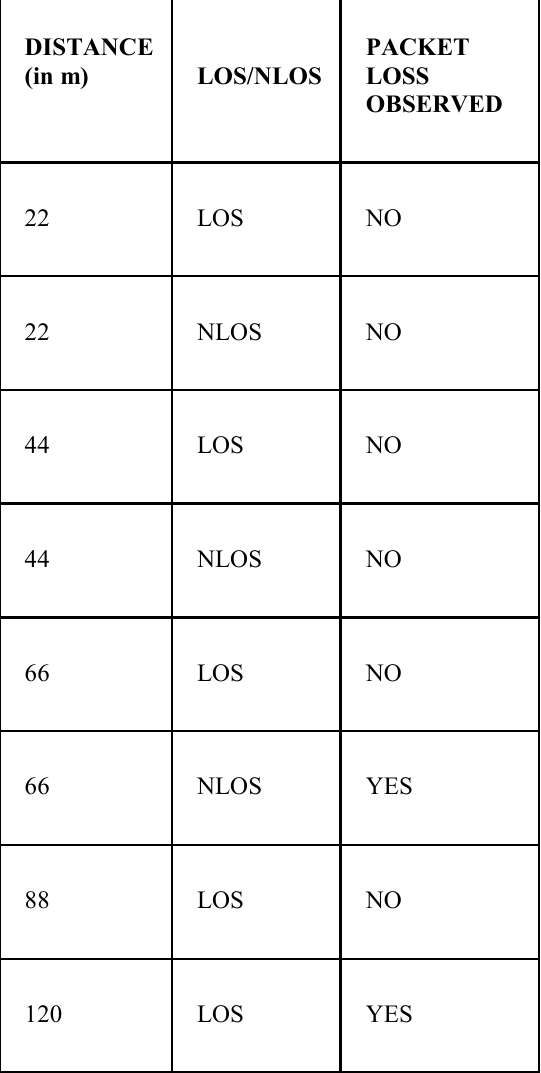
Table 2 . Range Testing of LoRa transceiver module